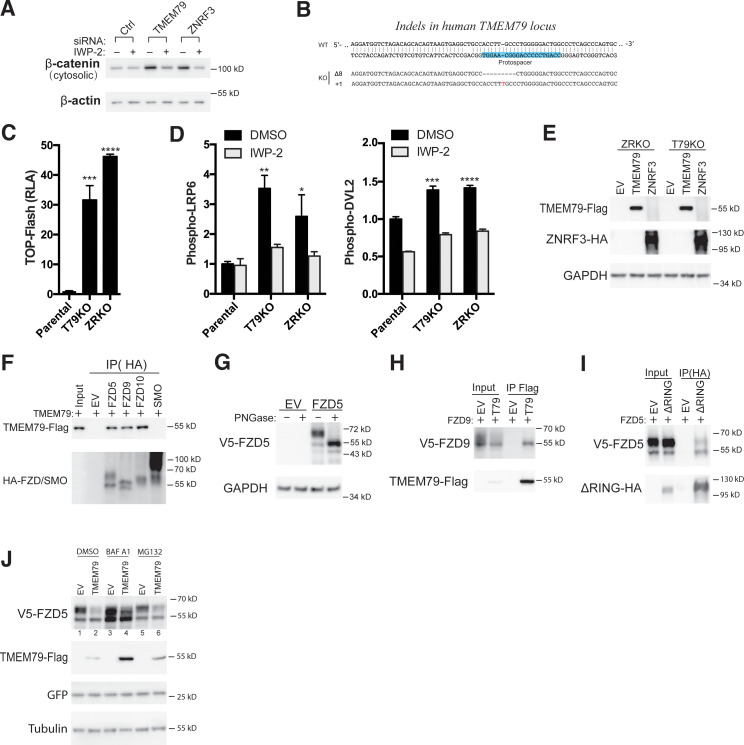
TMEM79 inhibits Wnt/β-catenin signaling by reducing surface level of frizzled receptor.(A) Depletion of TMEM79 or ZNRF3 via an siRNA in HEK293T cells induces cytosolic β-catenin accumulation, which is prevented by IWP-2. (B) Genomic DNA sequencing showing indel (frame shift) mutations of TMEM79 alleles in the T79KO clone picked/used. Two clones were picked and tested with indistinguishable results (data not shown). (C) Top-flash reporter is activated comparably and strongly in T79KO cells and ZRKO cells. (D) Figure 3B quantification. Phospho-LPR6 (pS1490) and phospho-DVL2 (the upper band) levels are measured and normalized to total LRP6 and DVL2 levels, respectively. (E) Overexpression of TMEM79 and ZNRF3 proteins in ZRKO and T79KO cells, respectively. (F) TMEM79 is co-IPed with FZD5 (positive control), FZD9, and FZD10, but not SMO (negative control). (G) Mature FZD5 (the upper band) is de-glycosylated by PNGase and converted to the lower band as un-glycosylated immature FZD5. (H) TMEM79 co-IPs preferentially the lower band of FZD9, likely the immature form, and reduces the level of upper bands of FZD9, which appear to be heterogenous, possibly due to heterogeneity of glycosylation. This is consistent with FZD9 maturation being inhibited by TMEM79. Other FZDs when overexpressed do not exhibit distinct bands of separable electrophoretic mobilities (data not shown) as do FZD5 most overtly and FZD9 to a lesser degree. (I) ZNRF3ΔRING, a mutant with the RING domain deletion, co-IPs mature FZD5 and immature FZD5 (possibly during ZNRF3ΔRING’s transit through the ER to PM). Because the full-length ZNRF3 reduces FZD levels, we employed ZNRF3ΔRING, which does not have the E3 ligase function, to avoid fluctuations of the FZD5 level in the co-IP assay. (J) Lysosome inhibitor bafilomycin A1 (BAF A1), but not proteasome inhibitor MG132, inhibits TMEM79-induced degradation of immature FZD5. BAF A1 increases both mature and immature forms of FZD5 (compare lanes 1 and 3). BAF A1 blocks TMEM79-induced degradation of immature FZD5, but does not increase mature FZD5 (compare lanes 3 and 4), consistent with the notion that TMEM79 prevents FZD maturation to the PM by shuttling FZD5 to the lysosome. MG132 does not affect levels of immature and mature FZD5 in the absence (compare lanes 1 and 5) or presence of TMEM79 (compare lanes 2 and 6). Thus it appears that ZNRF3 and RNF43 promote degradation of mature FZD5 through the lysosome (Koo et al., 2012), whereas TMEM79 promotes degradation of immature FZD5 through the lysosome.Figure 3—figure supplement 1—source data 1.Raw data for Figure 3—figure supplement 1.